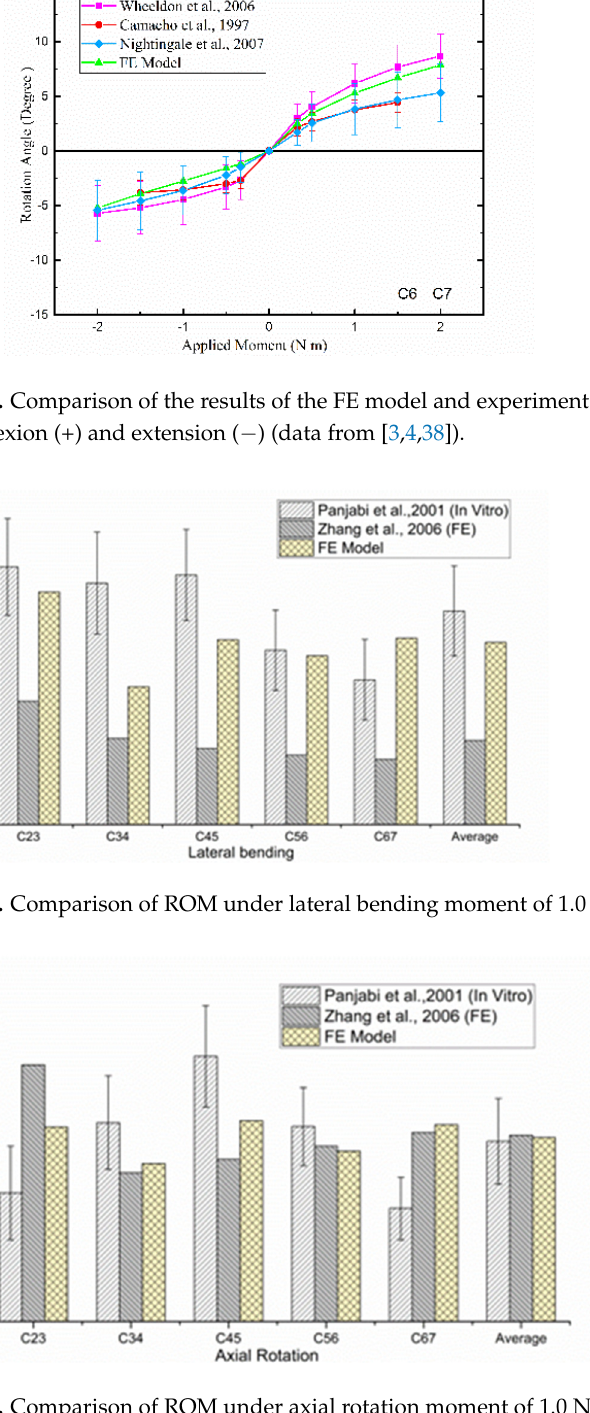
Figure 5. Comparison of ROM under axial rotation moment of 1.0 Nm.